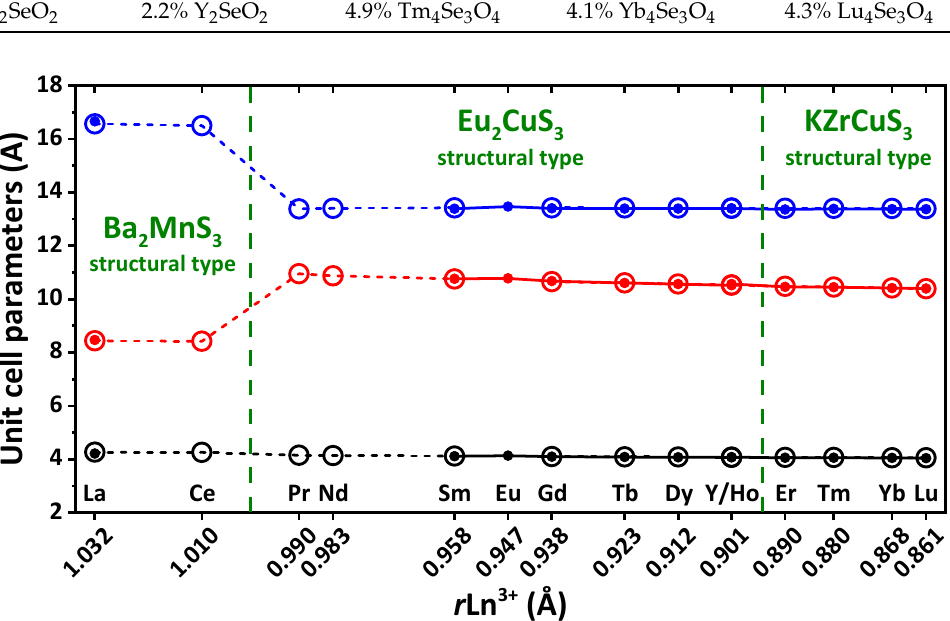
Figure 2. The calculated (open circles) and experimental (filled circles) unit cell parameters in the structures of EuLnCuSe 3 (Ln = La, Sm, Eu [31], Gd, Tb, Dy, Ho, Y, Er [60], Tm, Yb, Lu). Black = a and b axes for space groups Cmcm and Pnma , respectively; red = c and a axes for space groups Cmcm and Pnma , respectively; blue = b and c axes for space groups Cmcm and Pnma , respectively. The distorted tetrahedra CuSe 4 are linked by vertex atoms yielding polymeric chains along the b axis for the structural types Ba 2 MnS 3 and Eu 2 CuS 3 , and along the a axis for the structural type KZrCuS 3 . In the structure of EuLaCuSe 3 , the polyhedron EuSe 7 is formed from two atoms of Se1 i , two atoms of Se1 ii , two atoms of Se2 i and one atom of Se3 (Table S4 in the Supplementary Materials) with all the Eu–Se distances being within the